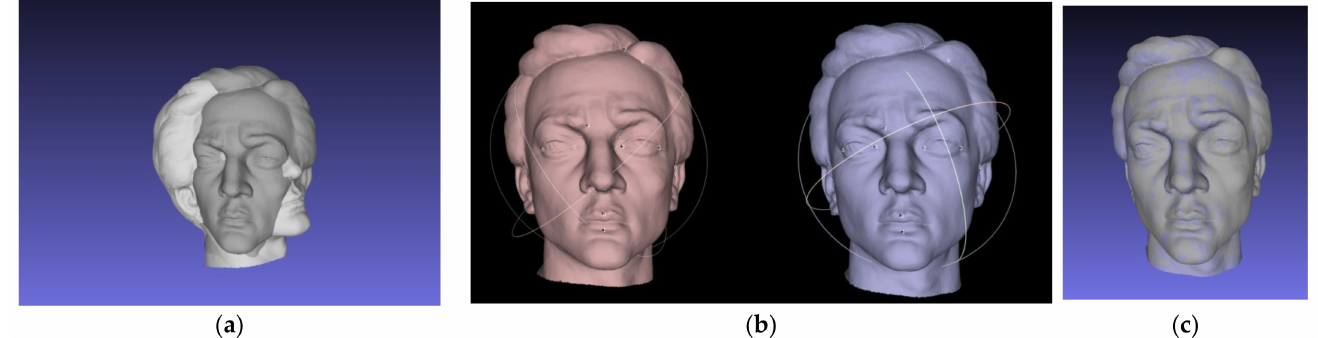
Figure 8. Aligning models in MeshLab software: ( a ) unaligned scanned models imported in MeshLab; ( b ) setting key points on the models for the aligning procedure; ( c ) aligned